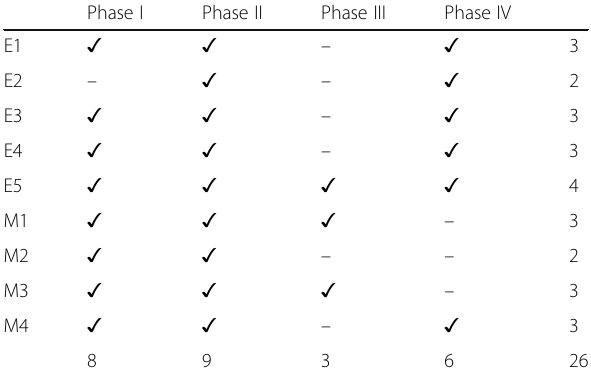
Table 1 Comparison of the simplified foresight model to